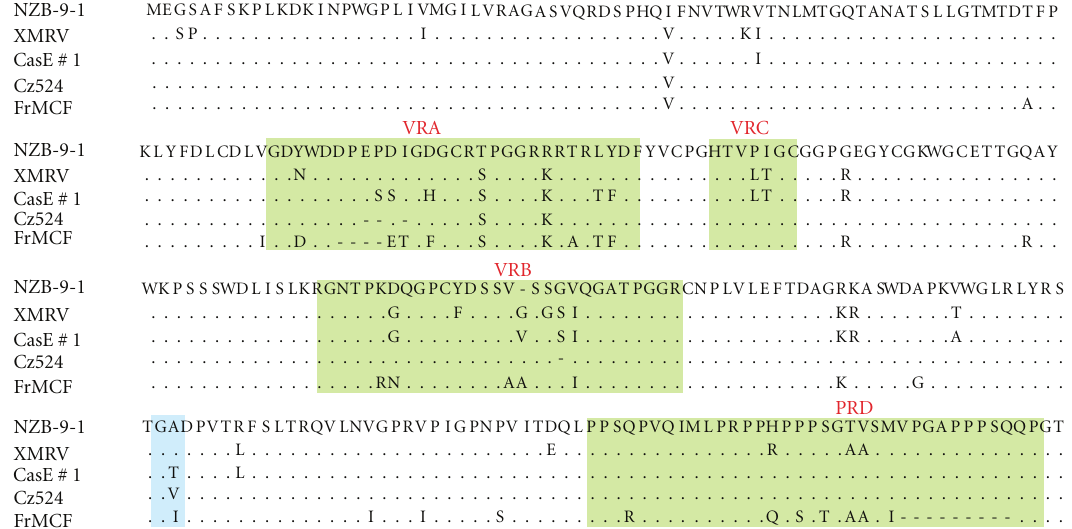
Figure 4: Alignment of the predicted amino acid sequences of the N-terminal portion of the Env sequences of various XP-MLVs. Included are the prototype NZB-9-1 X-MLV, the Friend FrMCF P-MLV, the wild mouse isolates CasE#1 and Cz524, and XMRV. Green blocks identify the three variable domains of the RBD and the PRD, and a blue block identifies two residues that influence species tropism [93].